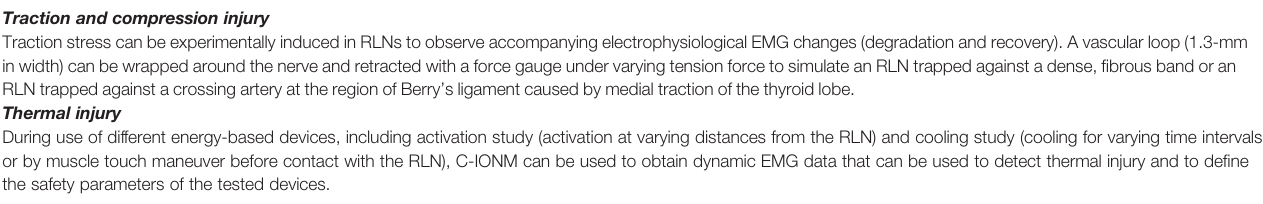
TABLE 3 | Common RLN injuries models used for IONM training courses in animal laboratories. Traction and compression